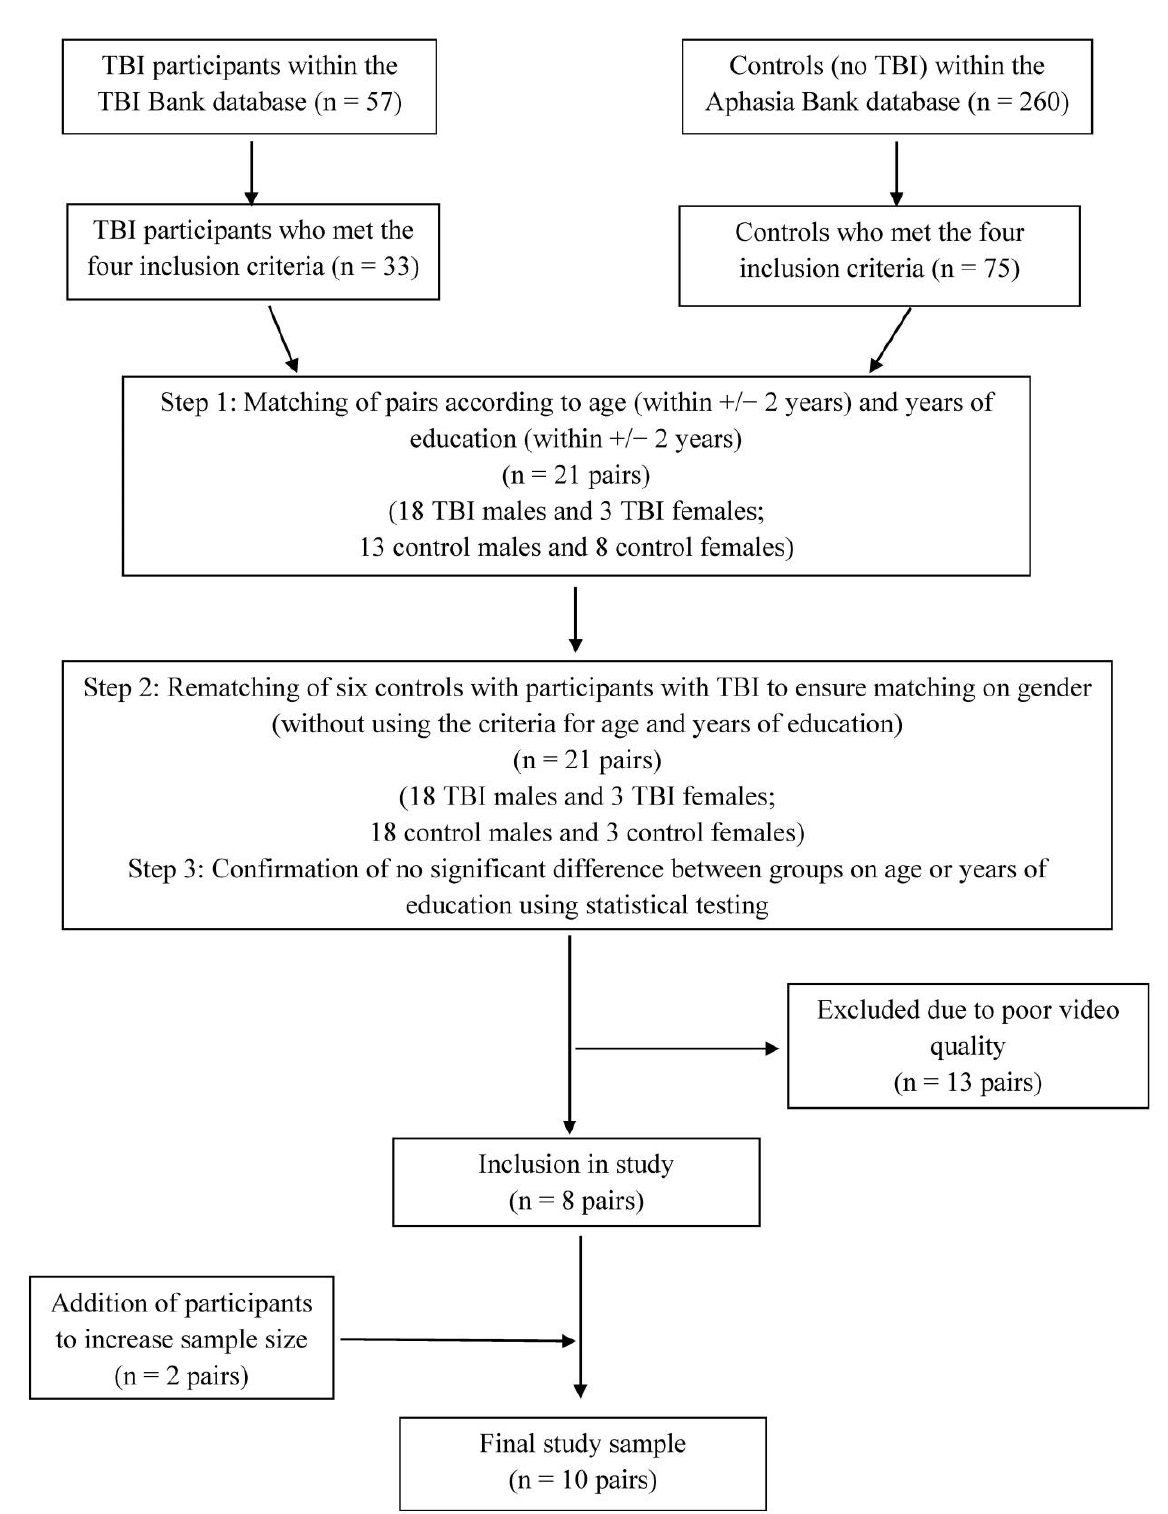
Figure 1. Flow diagram for study